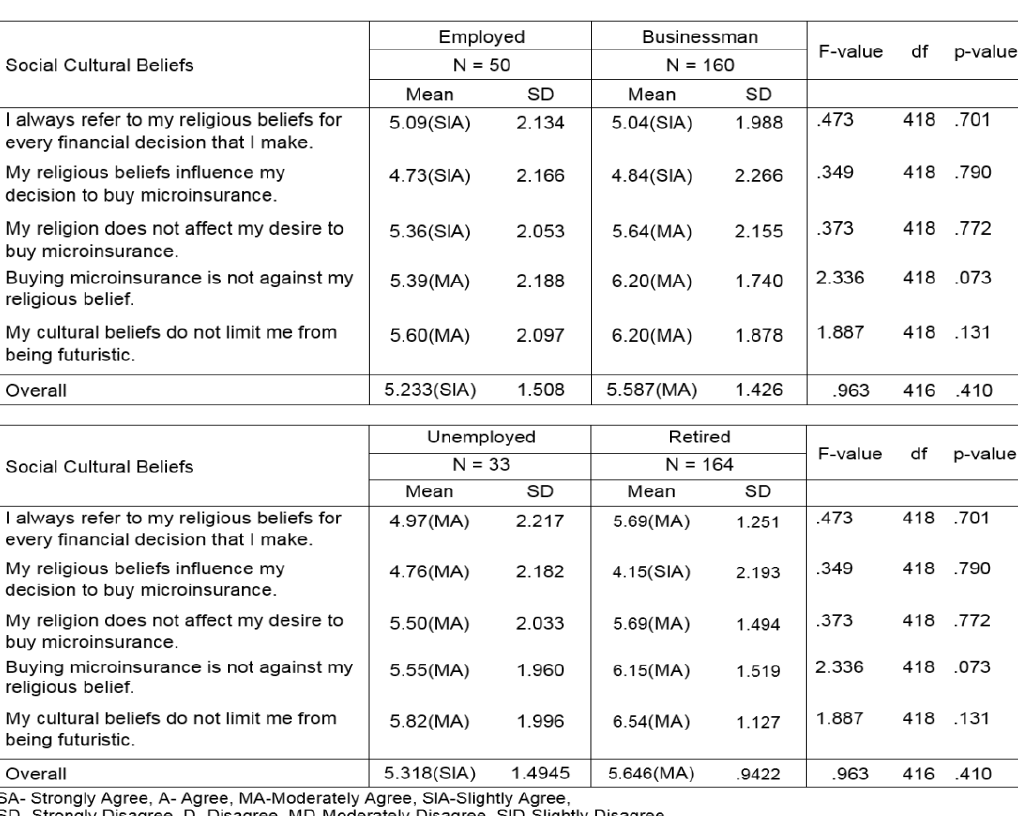
Table 4: Level of Agreement of the Respondents on the Social Cultural